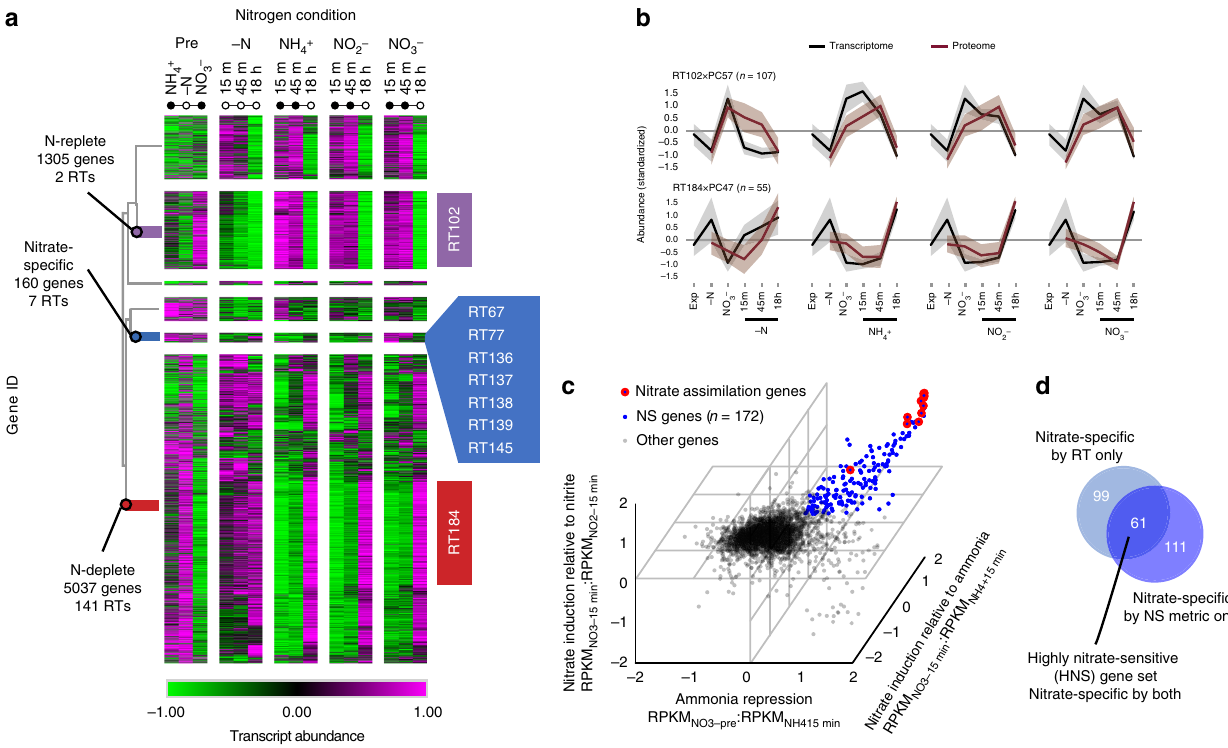
Fig. 1 Identi fi cation of highly nitrate-sensitive (HNS) gene set. a Transcriptome from the N short experiment. Heatmap shows average